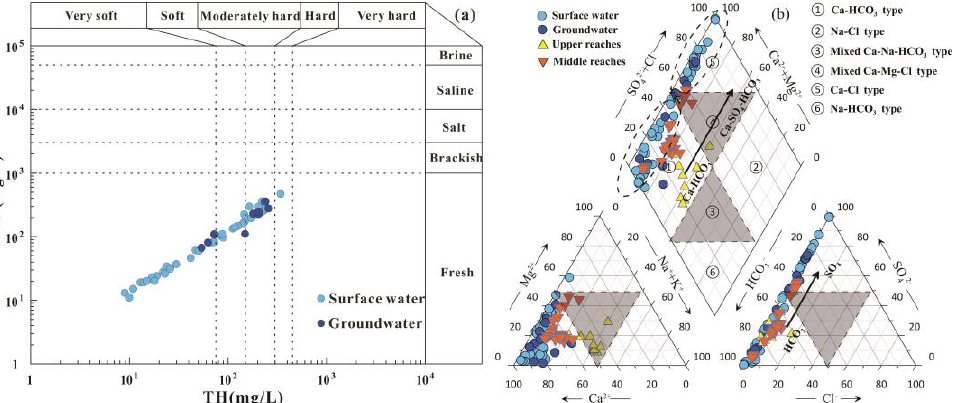
Figure 3. TDS and TH scatter diagram ( a ) and Piper trilinear diagram ( b ) of surface water and groundwater in the Lower reaches of Yarlung Zangbo River. Data are from Tables 1 and 2.